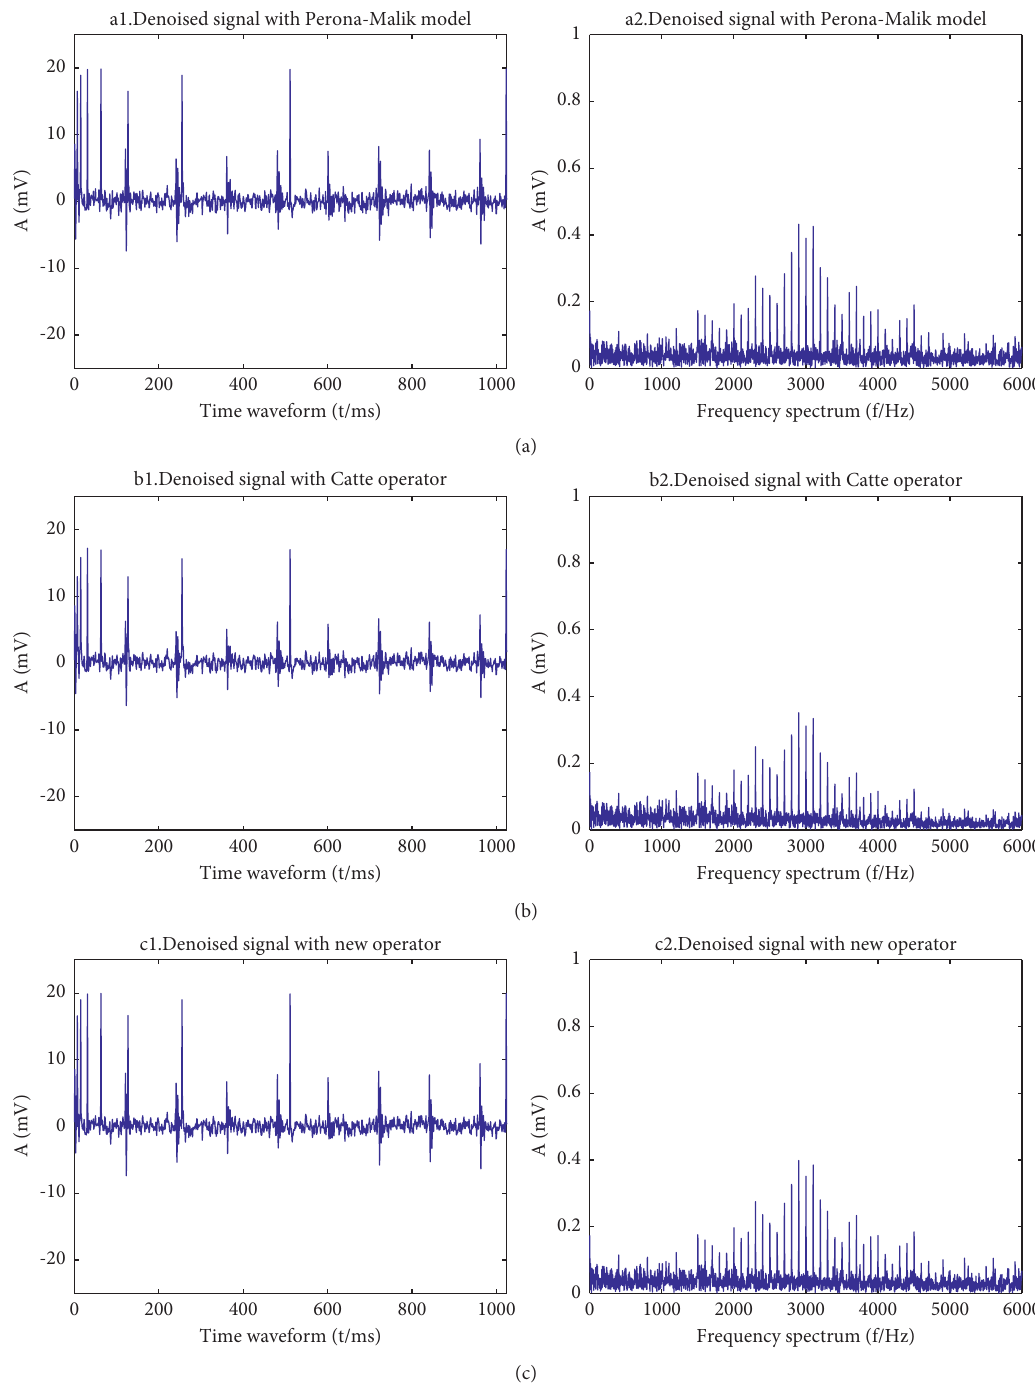
Figure 3: Comparison between PDE model and its improved models. (a) Denoised signal with Perona–Malik model. (b) Denoised signal with Catt´e operator. (c) Denoised signal with new